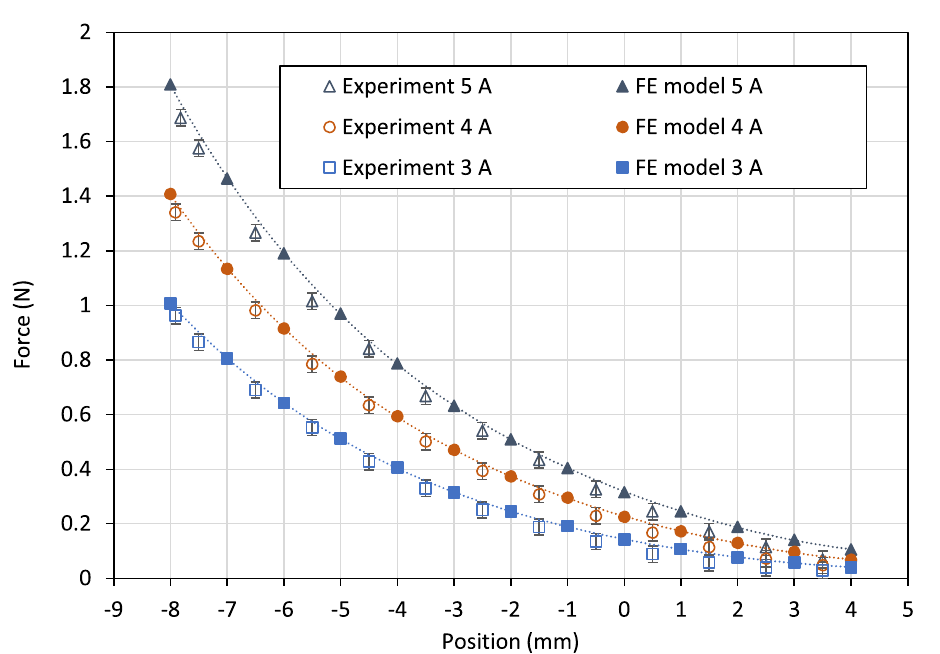
Figure 12. Finite element modelling results with current of 5 A through coil A: ( a ) flux density plot; ( b ) computed field strengths and fluid pressures at piston surfaces.